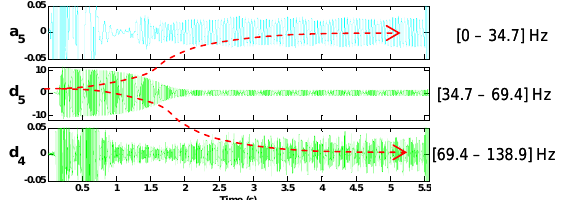
Fig. 13. 6-level DWT of the startup current for the machine with mixed